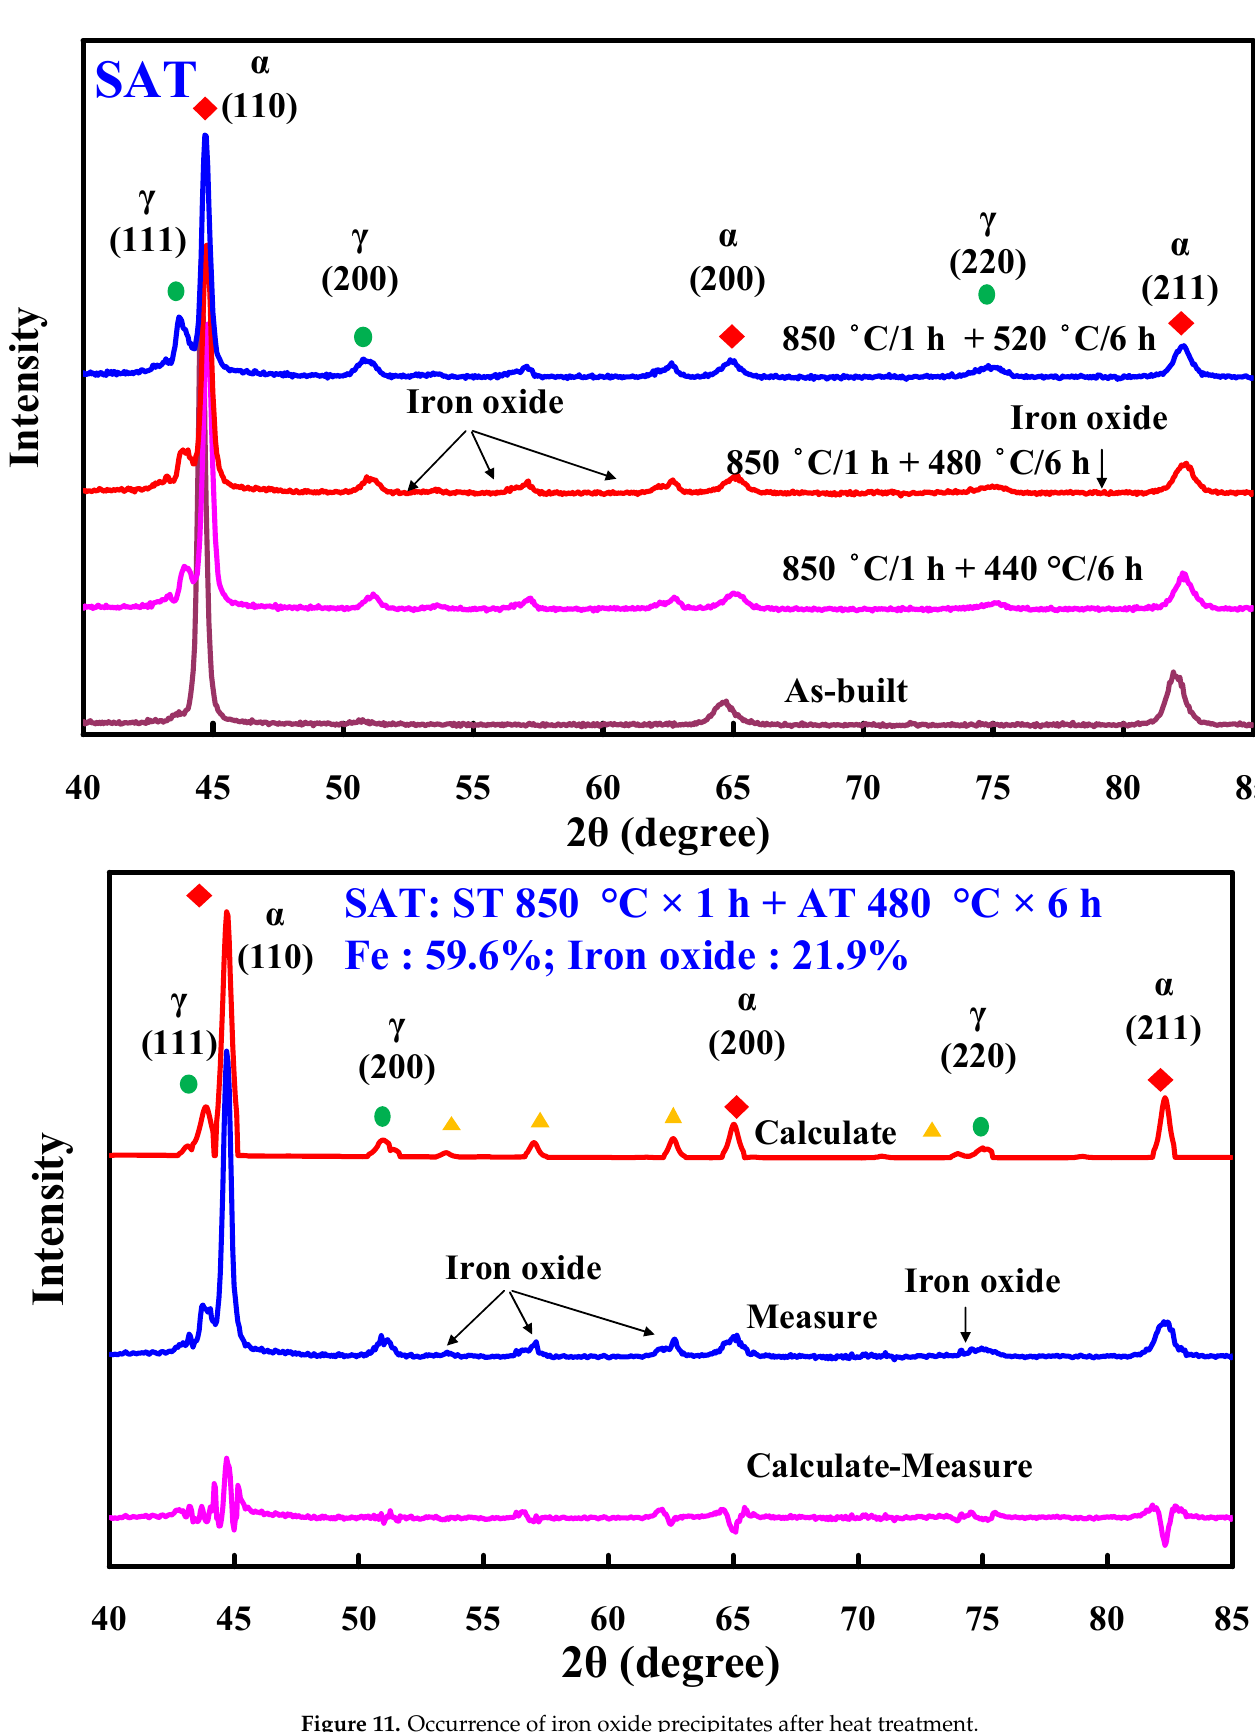
Figure 11. Occurrence of iron oxide precipitates after heat